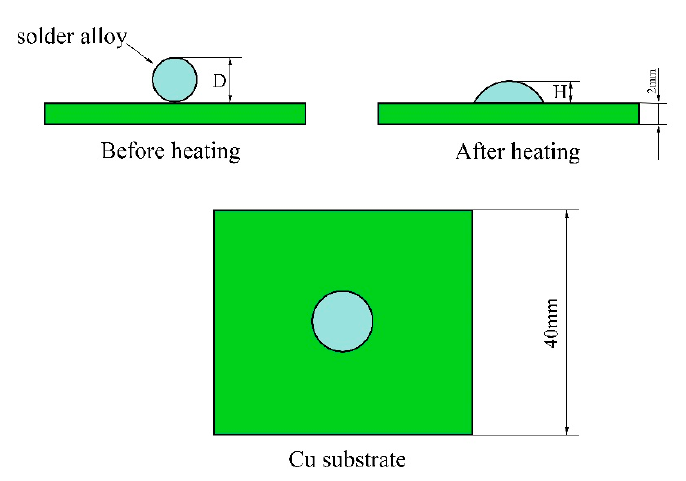
Figure 1. Schematic diagram of the wetting test process.